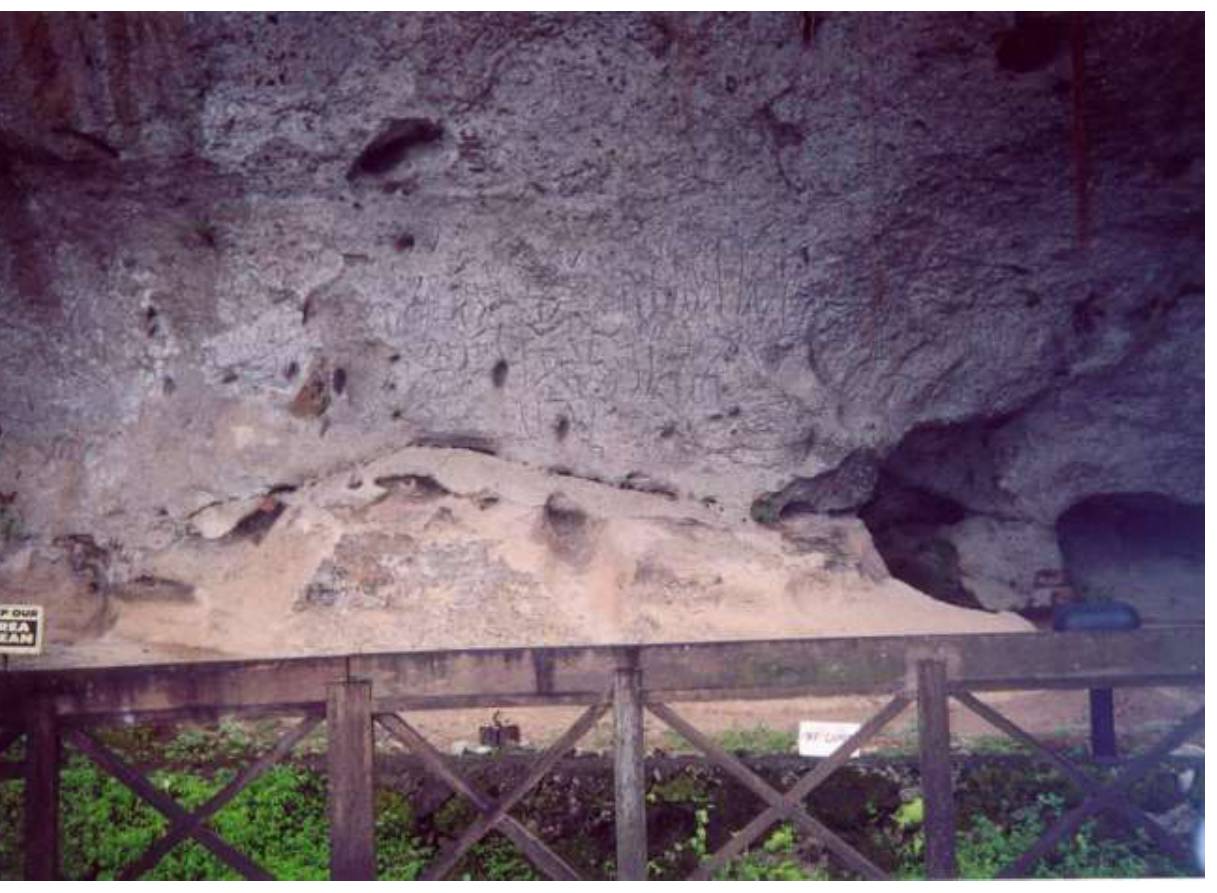
Figure 13. The Angono Petroglyphs in Rizal province is one of the best-known sites in the Philippines. Photo: Grace